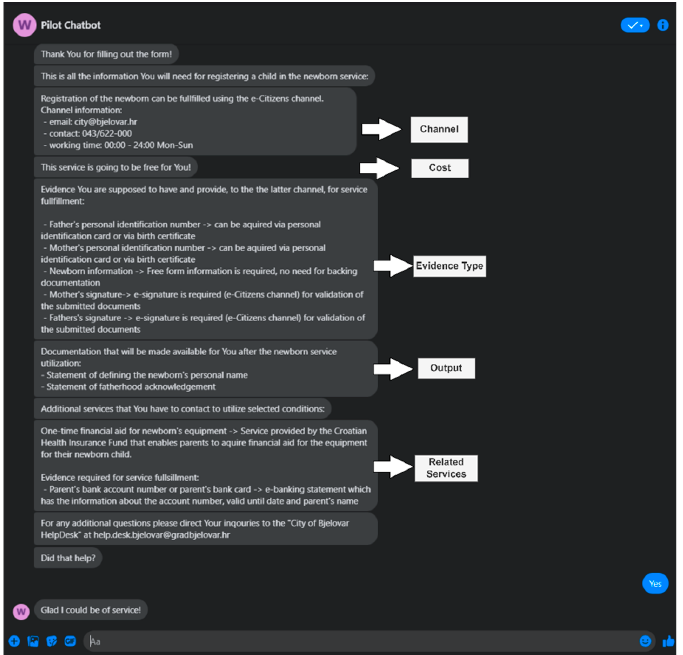
Figure 8. Personalized information provided by the Chatbot for the “Newborn PS”.